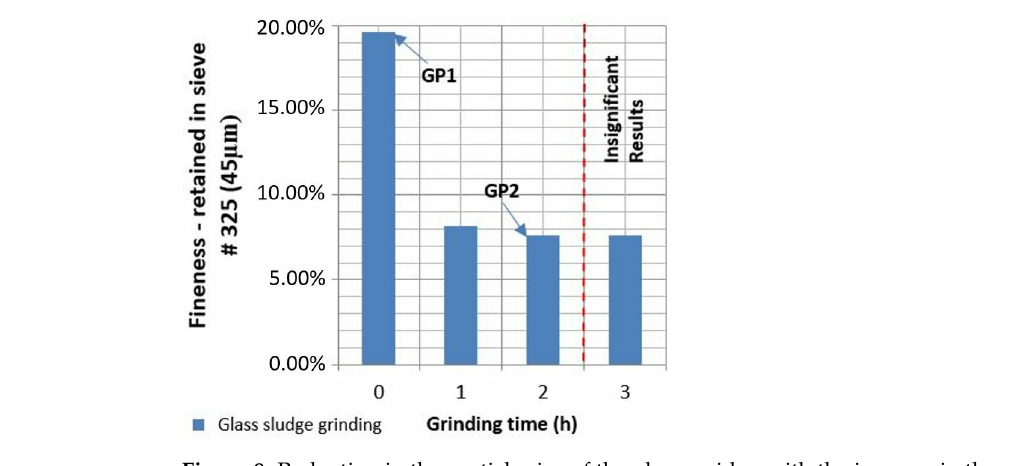
Figure 8. Reduction in the particle size of the glass residue with the increase in the grounding time.